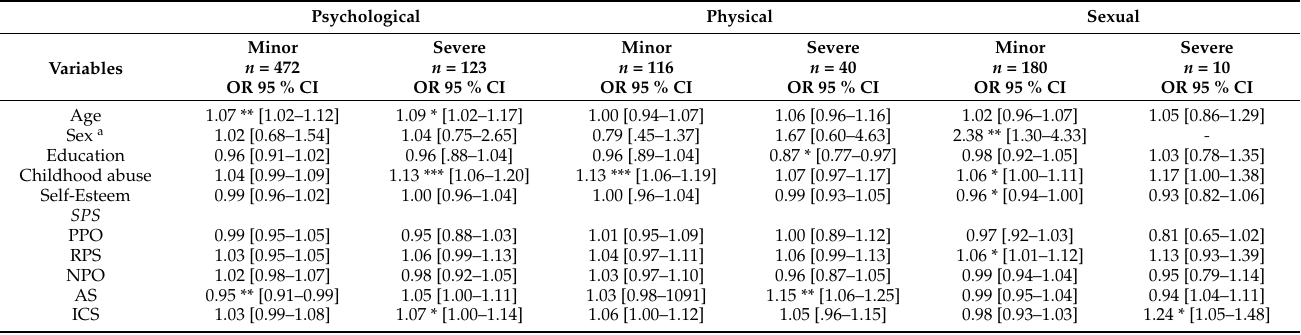
Table 3. Results of Multinomial Logistic Regressions on Severity of IPV, Self-Esteem and